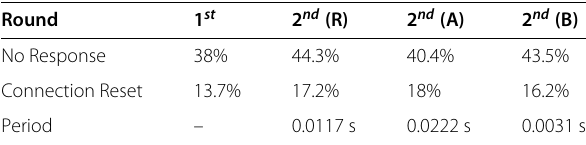
Table 5 Comparison of the probabilities of the DUT responding with “No Response” or “Connection Reset” and the execution time of the whole test Round 1